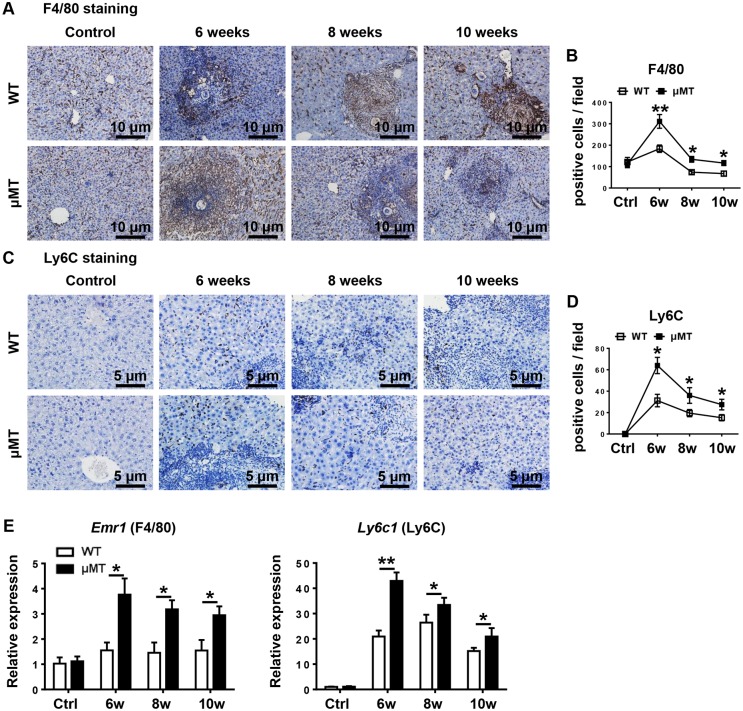
F4/80 and Ly6C expression are increased in the liver of μMT mice after S. japonicum infection.WT mice and μMT mice were infected with 18–20 cercariae of S. japonicum, and liver samples from these mice were harvested at the times indicated after infection. Comparisons were made with uninfected control mice. (A, C) Liver sections were stained with F4/80 (A), and Ly6C (C). Original magnification, × 200 for F4/80, × 400 for Ly6C. (B, D) Numbers of F4/80- and Ly6C-positive cells per field are counted. (E) Relative mRNA expression of F4/80 and Ly6C in liver tissues was determined by quantitative real-time PCR. Genes were normalized to the housekeeping gene Actb as an internal control. Data represent mean ± SD; n = 8–10 mice per time point from two independent experiments. *p < 0.05, **p < 0.01, versus WT mice.